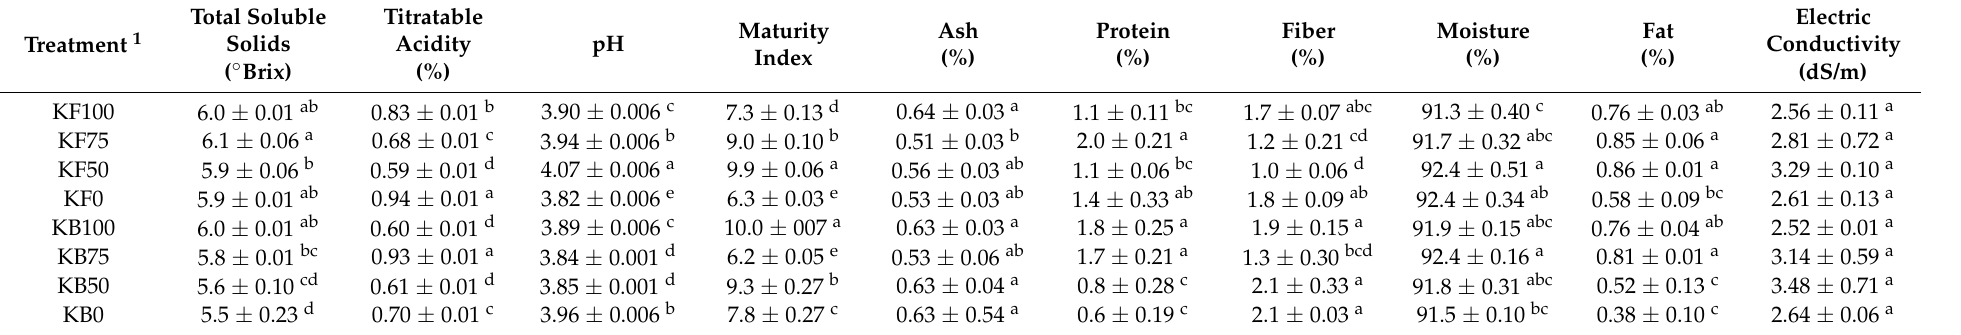
Table 4. Physicochemical parameters of the tomatillo fruits in the evaluation of the biofertilizing effect of Acinetobacter calcoaceticus UTMR2 in tomatillo plants ( Physalis ixocarpa Brot. cv. “c á scara morada”) at different doses of